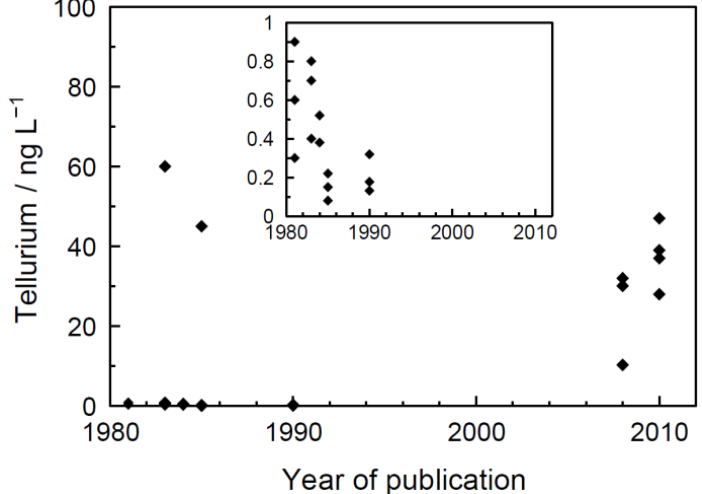
Figure 2. Published tellurium concentrations for surface seawater as a function of their year of publication. The insight shows the same data with a different scale in the y -axis. Data from [11,12,15–22].